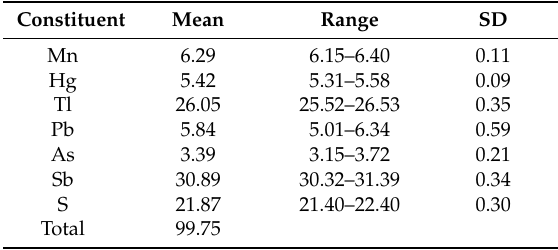
Table 2. Chemical data (wt %) for